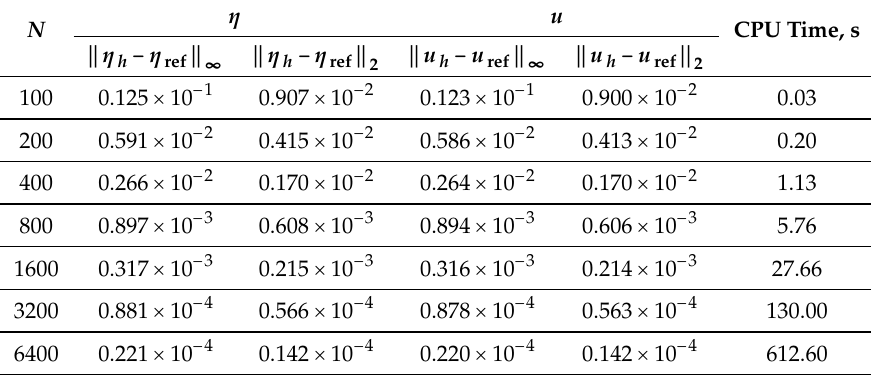
Table 6. The numerical solution errors measured at the final simulation time t = T f on a moving grid. The reference solution is given be Equations (25) and (27). All numerical parameters for this simulation are reported in Table